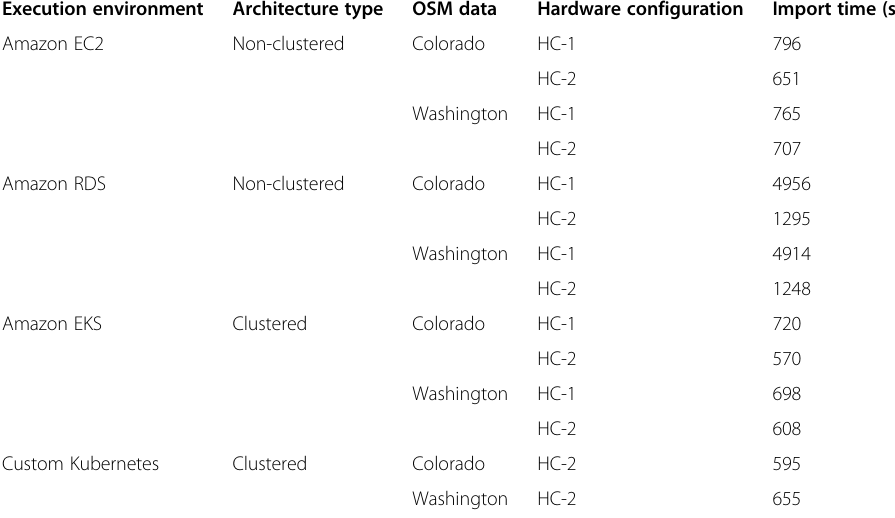
Table 2 Import time for considered execution